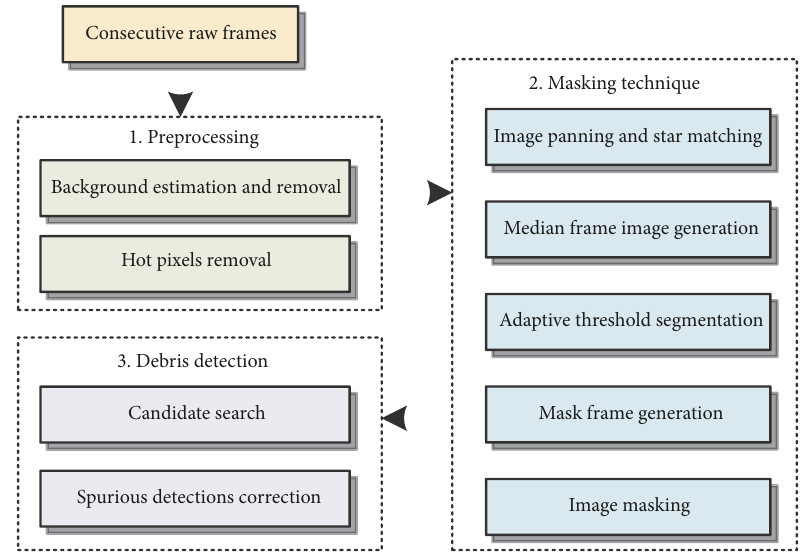
Figure 1: Block diagram of the proposed automatic